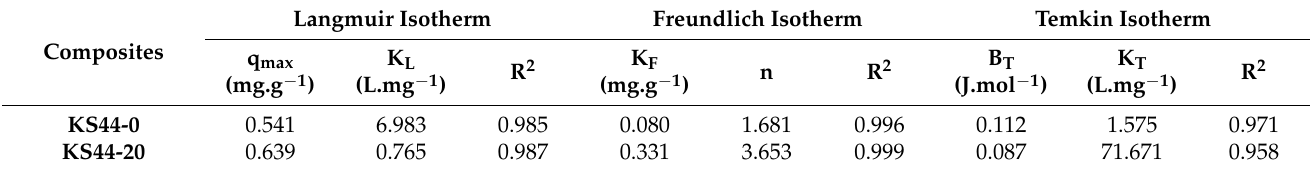
Table 4. Langmuir, Freundlich and Temkin isotherm model parameters for RhB adsorption on KS44-0 and KS44-20